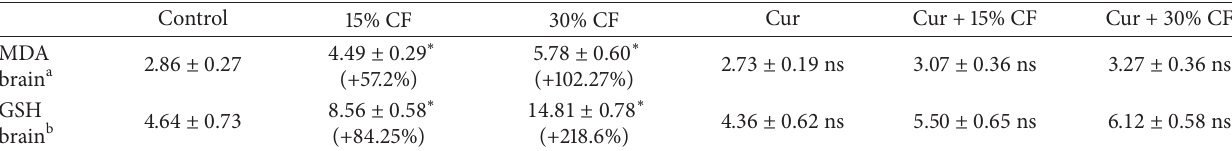
Table 1: Effects of carbofuran and curcumin on the levels of MDA and GSH in the brain stem of rat.